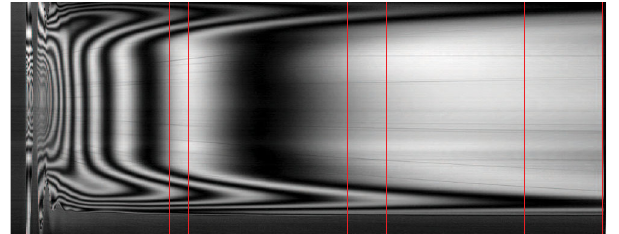
FIG. 13. Intensity line profile for different times. From left to right, the corresponding time of the red lines are 291, 331, 658, 738, 1023, 1183 ms. They form three time intervals: 291 – 331 ms, 658 – 738 ms, and 1023 – 1183 ms.